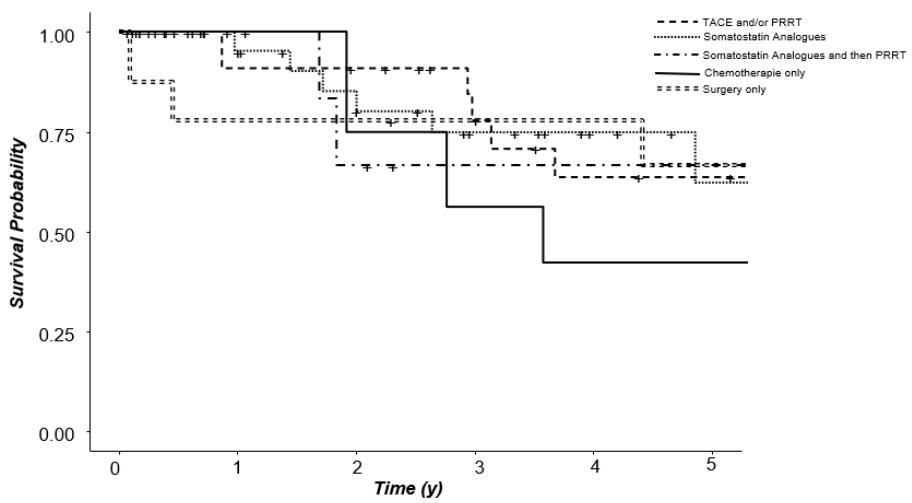
Figure 5. Survival probability, Kaplan–Meier analysis; reference group 2 (SSA only).